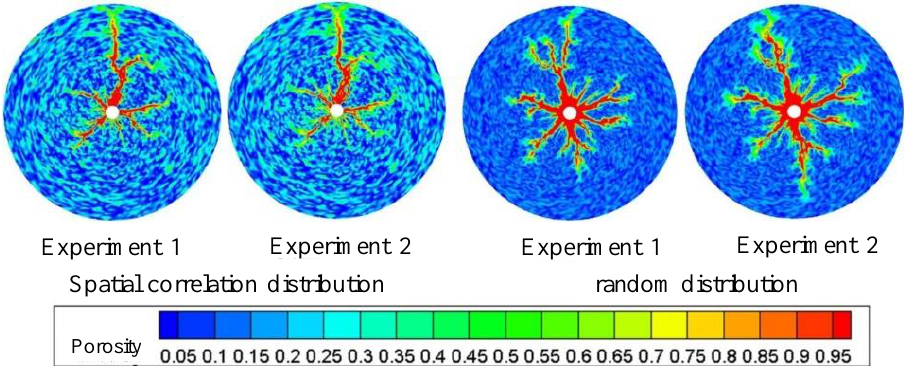
Figure 17. Simulated etching wormhole morphology obtained by CT scanning the rock end face gelled acid treated.